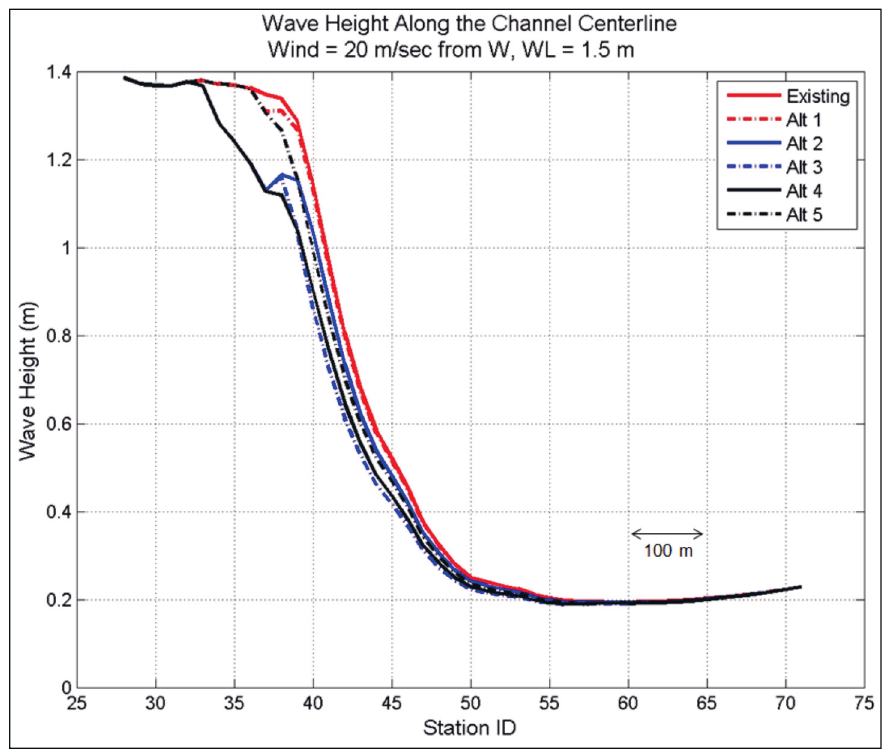
Figure 22. Model wave heights in the west channel for 50-year design wind from W and WL = 1.5